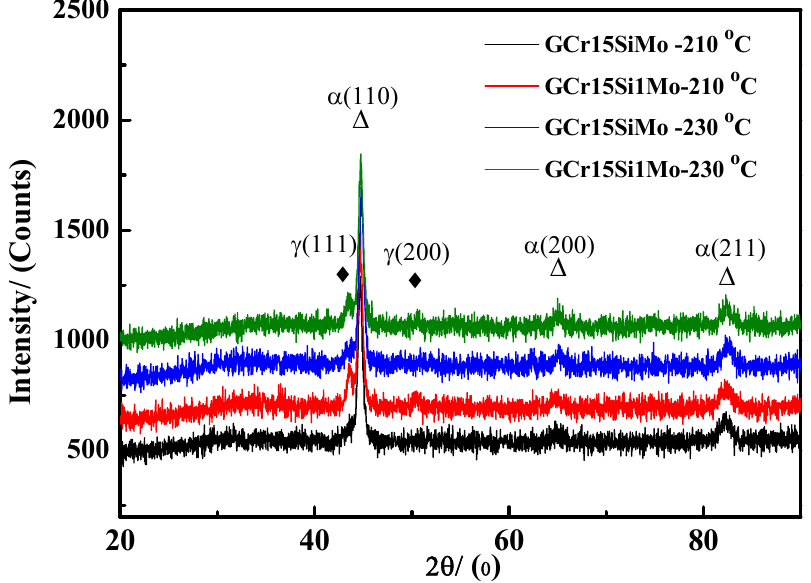
Figure 7. XRD profiles of the steels austempered at different temperatures for 8 h.